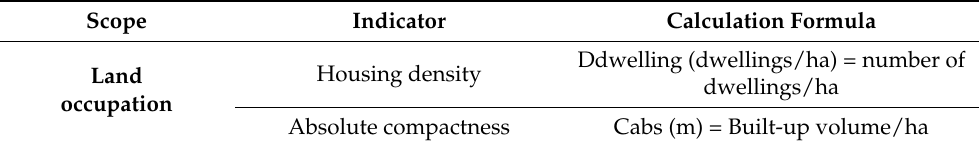
Table 2. Indicators used in the scope of Land Occupation.